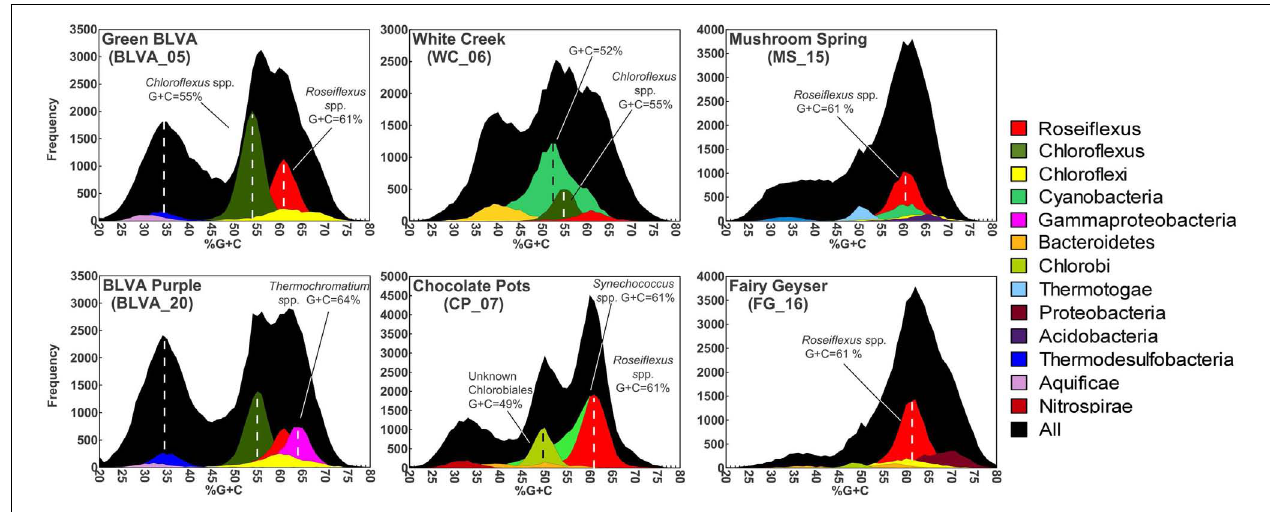
plot of all sequence reads (black) versus G + C content (%) is shown with corresponding taxonomic analysis (MEGAN-“blastx”) as indicated by the color key